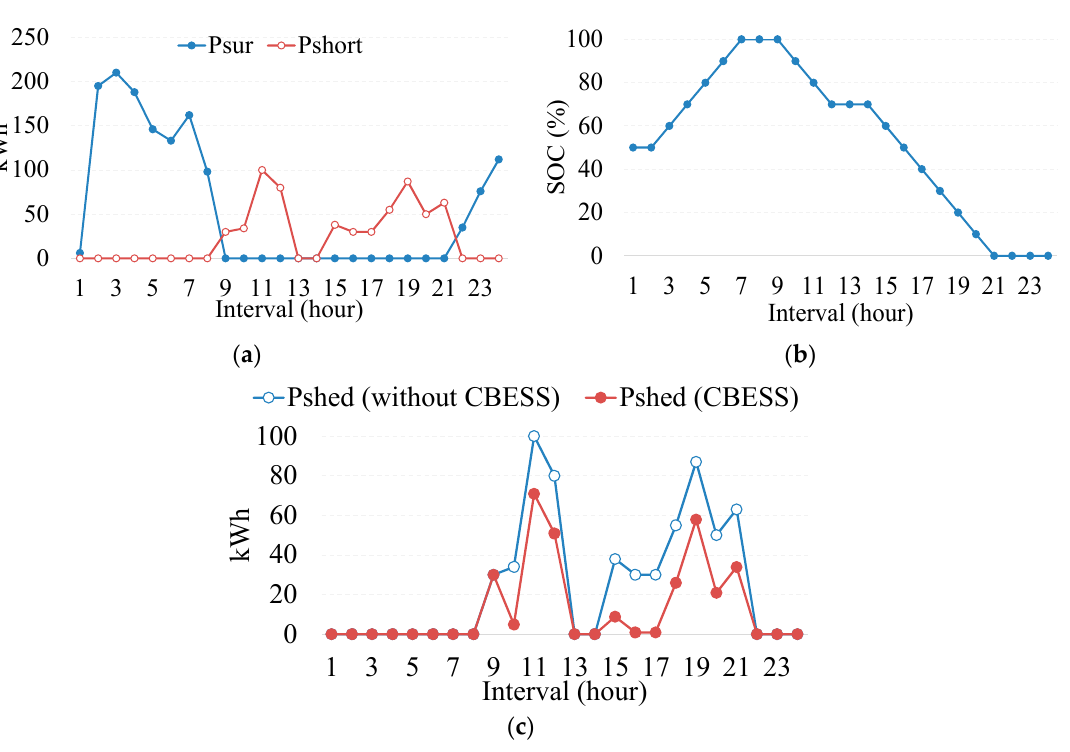
Figure 9. Operation of MG and CBESS in islanded mode: ( a ) the amount of surplus/shortage power in MG; ( b ) the optimal operation of CBESS by centralized EMS; ( c ) the load shedding amount in MG.